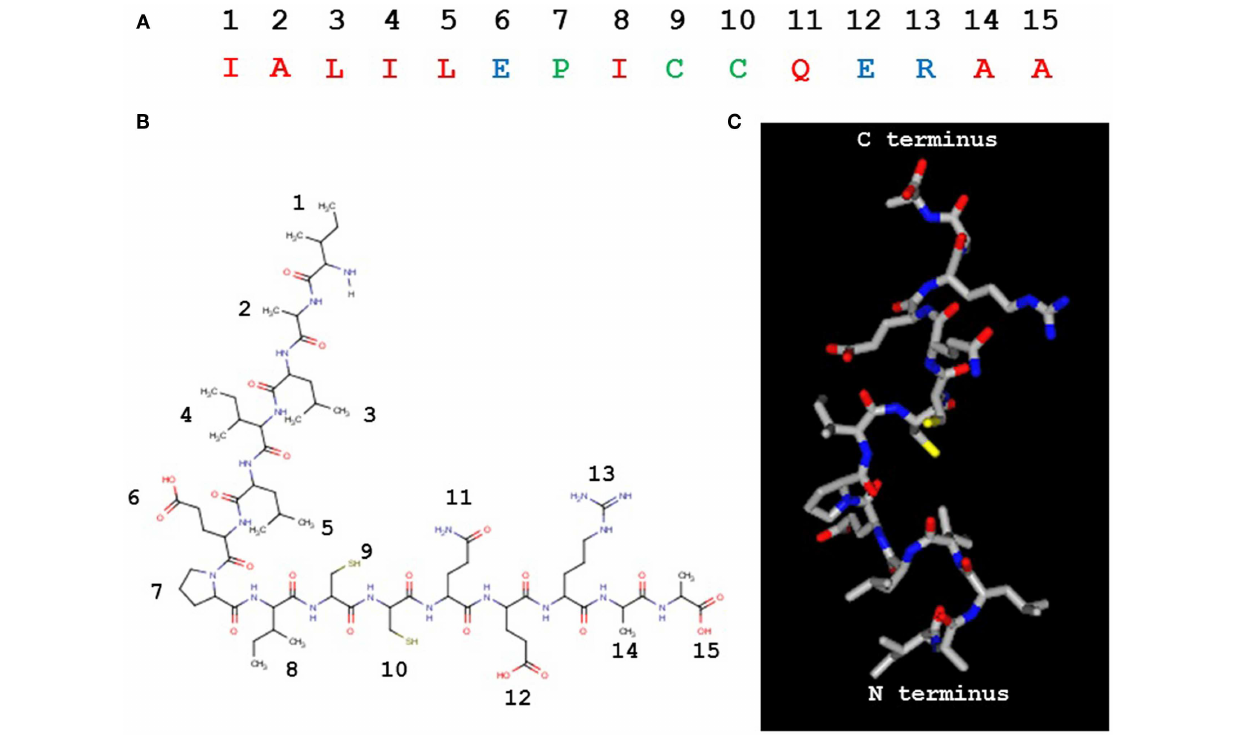
FIGURE 4 | Peptide inhibitors of complement C1 derivative PA . (A) The 15 residue PA molecule is made up of 9 hydrophobic (red), 3 polar/charged (blue), and 3 intermediary (green) amino acid residues. (B) A linear version of the PA molecule illustrating the amino acid side chains. (C) A structural model of PA. (B,C) Created in